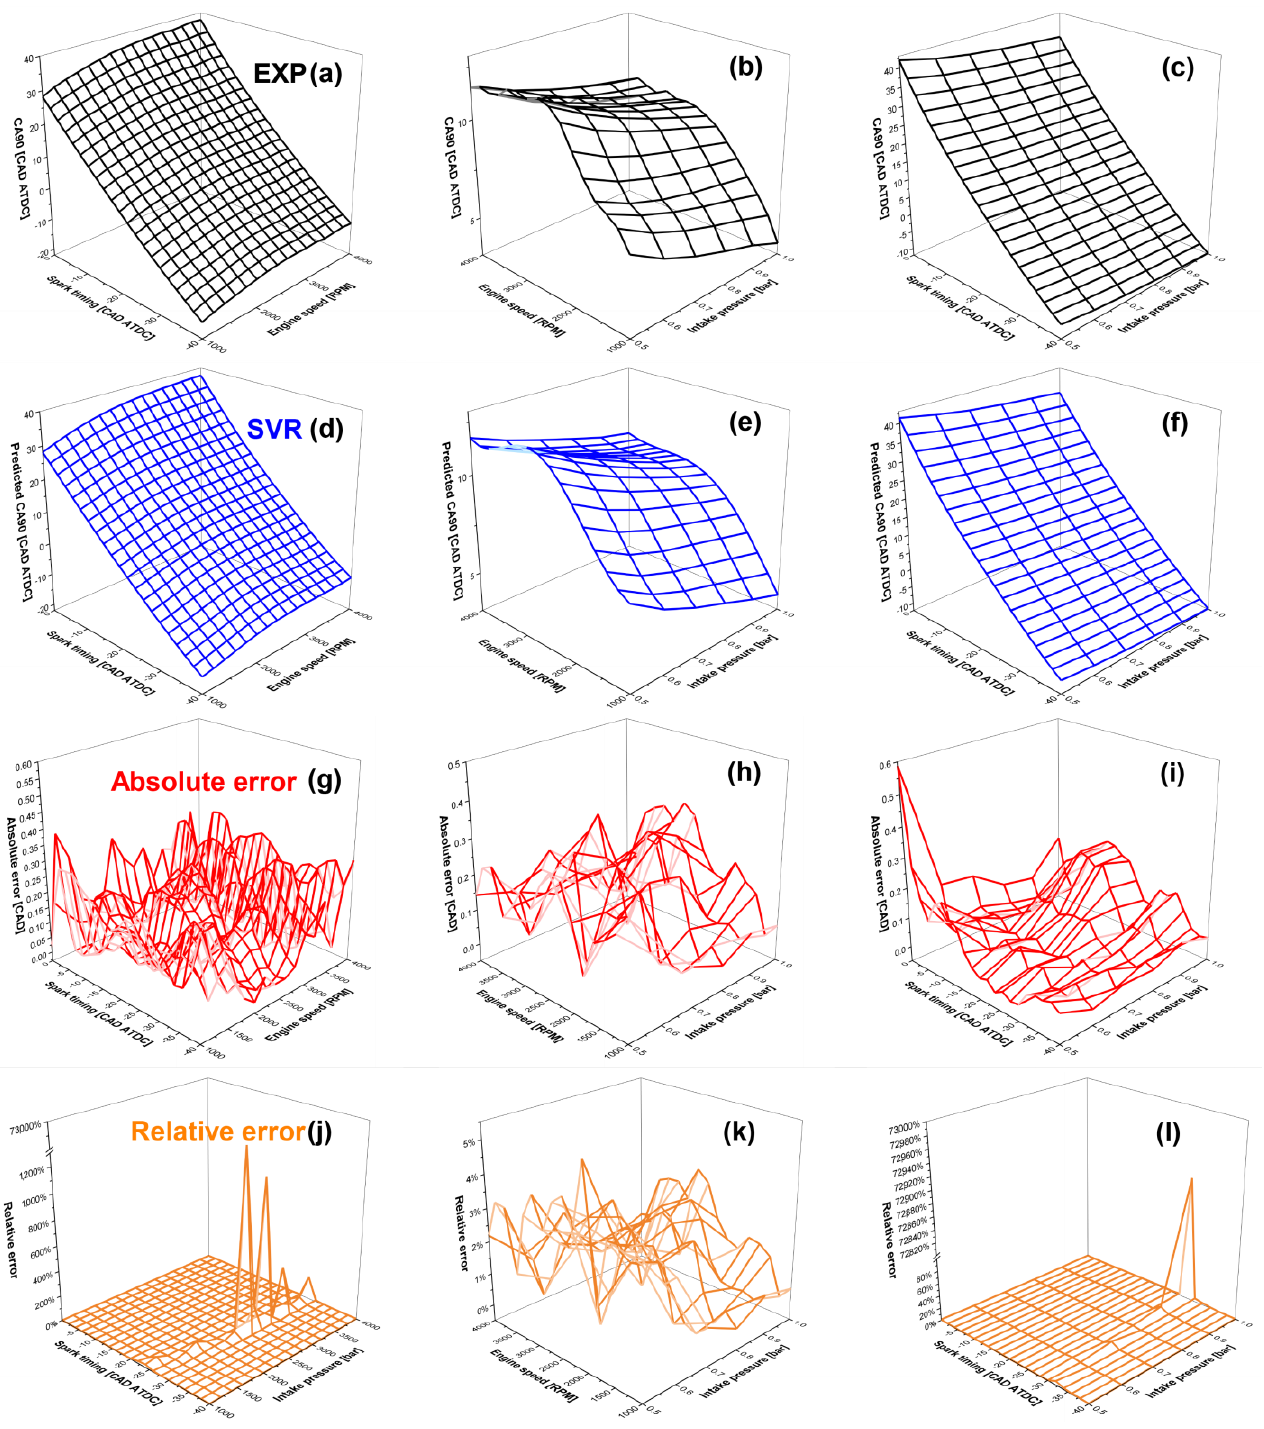
Figure 16. CA90 versus different operation parameters combination. ( a , d , g , j ) Prediction performance when spark timing and engine speed change (intake pressure = 1 bar); ( b , e , h , k ) prediction performance when engine speed and intake pressure change (spark timing = − 20 CAD ATDC); and ( c , f , i , l ) prediction performance when spark timing and intake pressure change (engine speed = 2600 RPM).